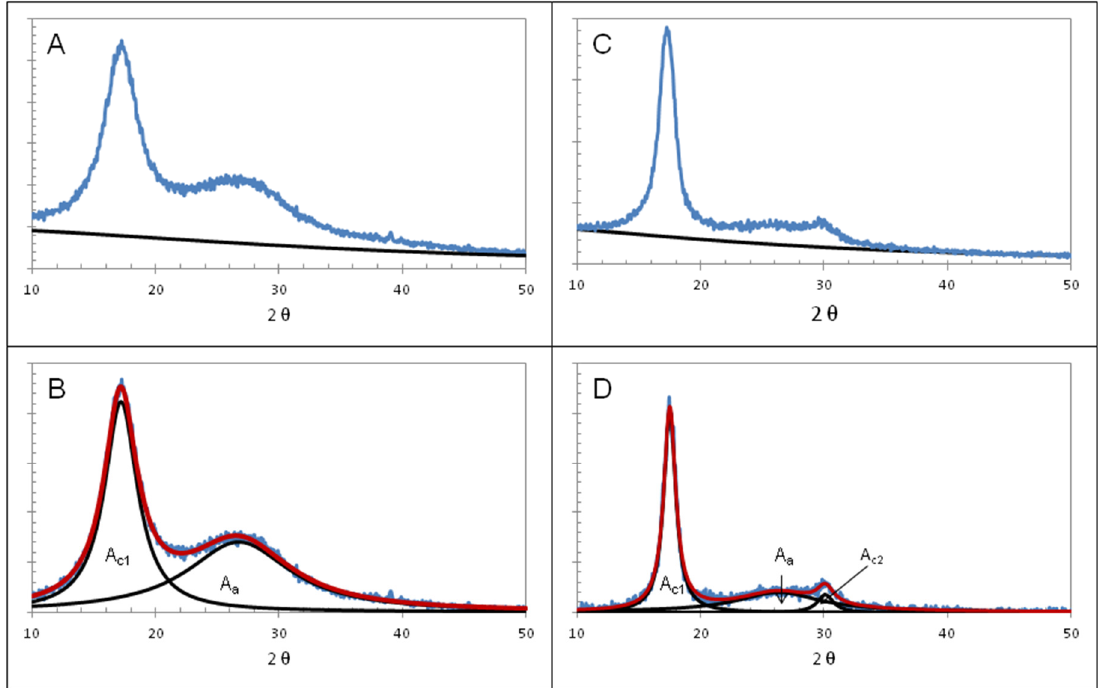
Figure 2. Schematic illustrating XRD spectra analysis for ( A , B ) as-spun and ( C , D ) annealed composite nanofiber specimens.